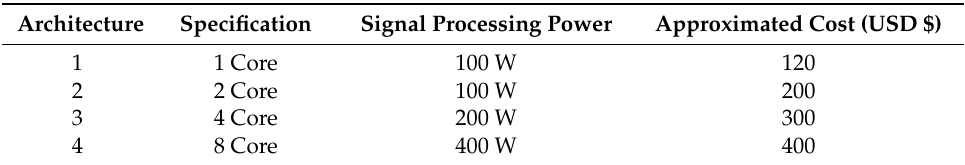
Table 2. Architecture of different signal processing units (SPUs) with their approximated power consumption and cost [34].